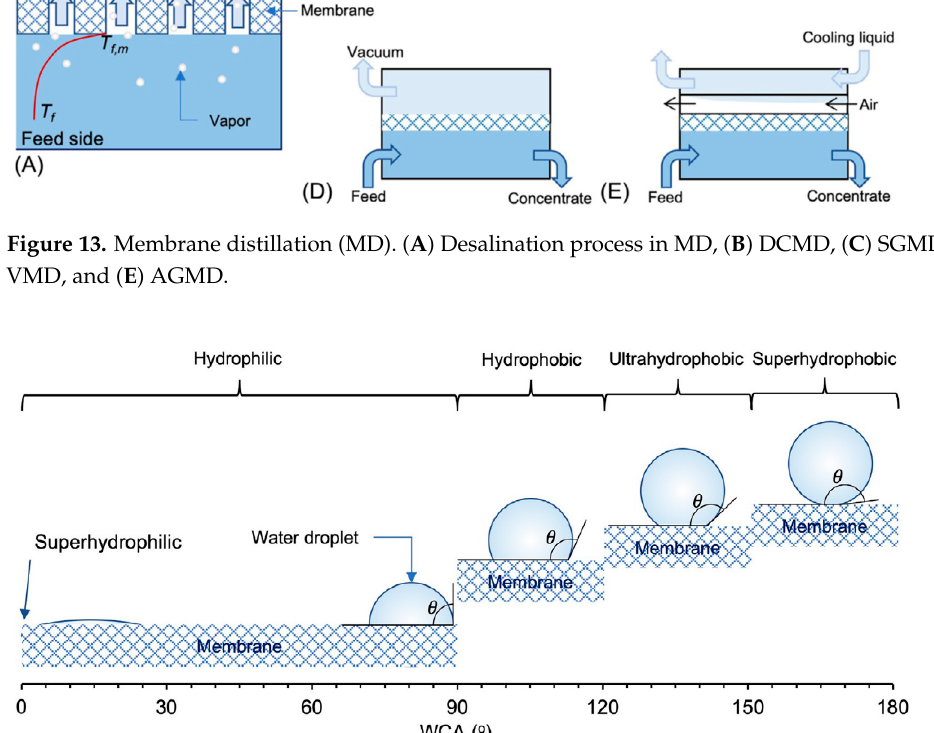
Figure 14. Water contact angles (WCA) on membrane surface with various wettability [45]. Repro- duced with permission from Wenten, I.G.; Khoiruddin, K.; Wardani, A.K.; Widiasa, I.N., Synthetic Polymeric Membranes for Advanced Water Treatment, Gas Separation, and Energy Sustainability; published by Elsevier,